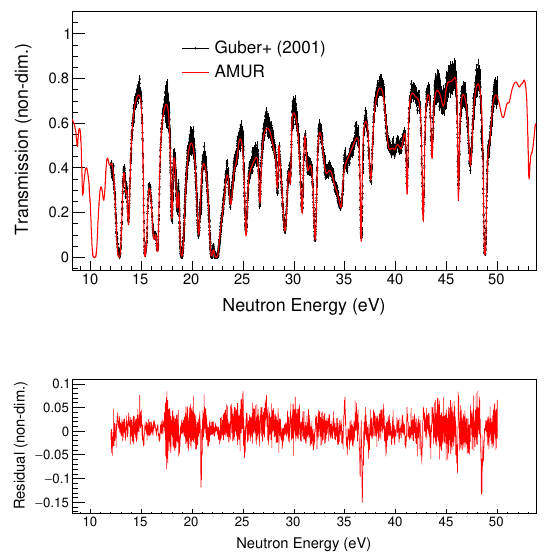
Figure 1. Neutron transmission on 233 U measured by Guber et al. [11] and calculated results of AMUR with resonance param- eter set (LRF = 3) in ENDF / B-VIII.0 [12] where the residuals are plotted in the bottom panel.